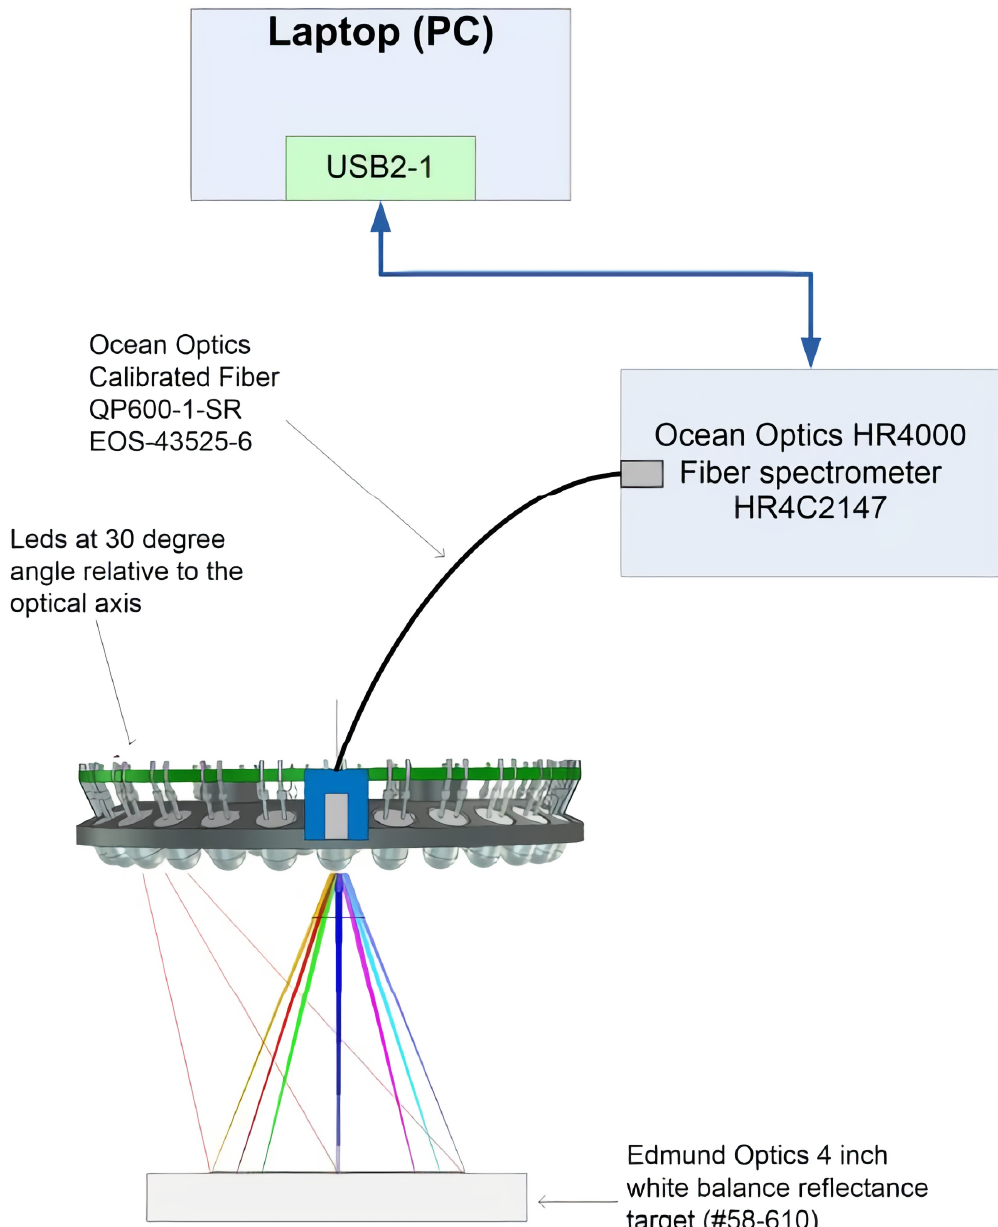
Figure 6. The setup was used in the spectral radiance measurements of LEDs and LED groups using the Ocean Optics Calibrated Fiber QP600-1-SR EOS-43525-6 and HR4000 spectrometer. Edmund Optics 4 inch white balance reflectance target (#58-610) was used in the